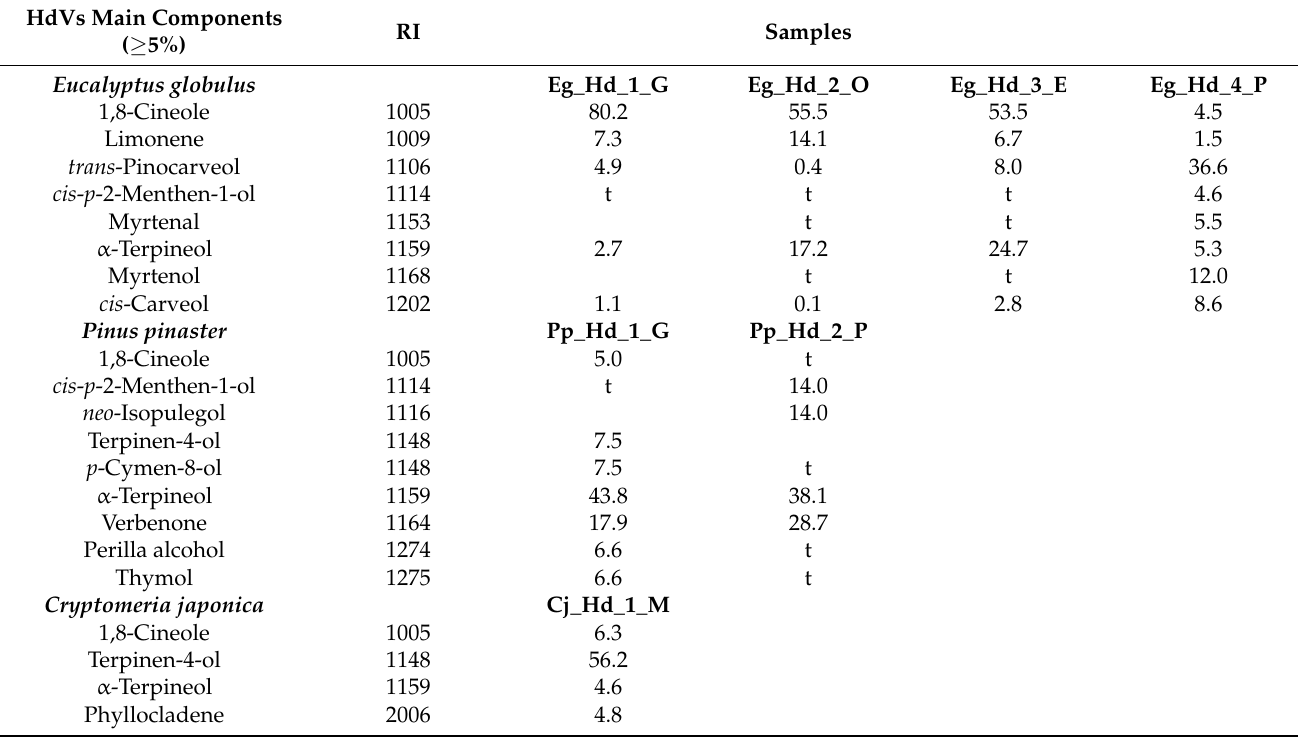
Table 2. Percentage composition of the main components ( ≥ 5%) of Eucalyptus globulus , Pinus pinaster and Cryptomeria japonica hydrolate volatiles (HdVs). For samples codes vide Materials and Methods